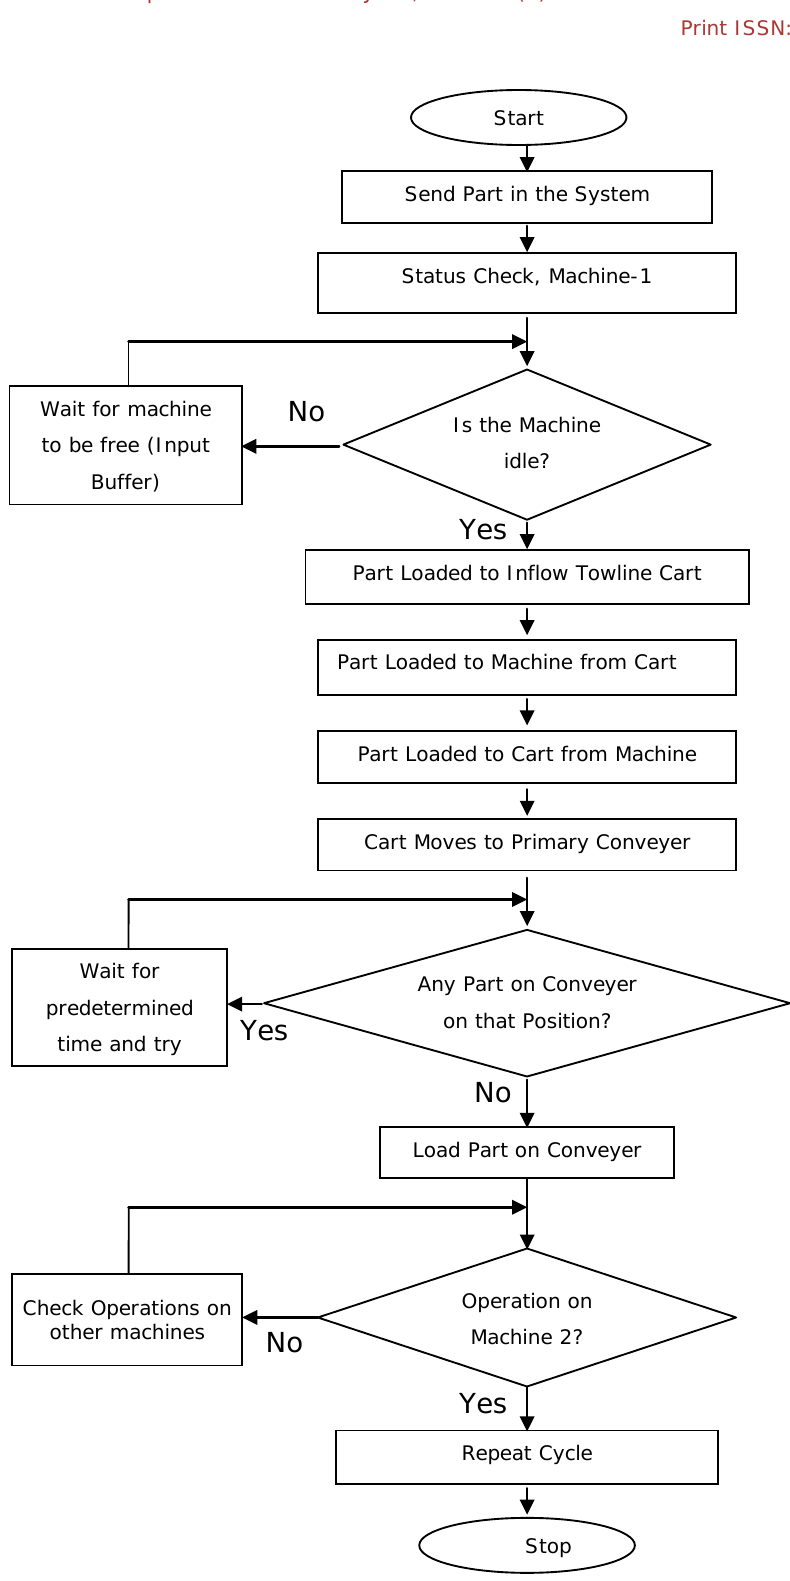
Figure 3. “Flow diagram for Loop Layout”. Source: Own